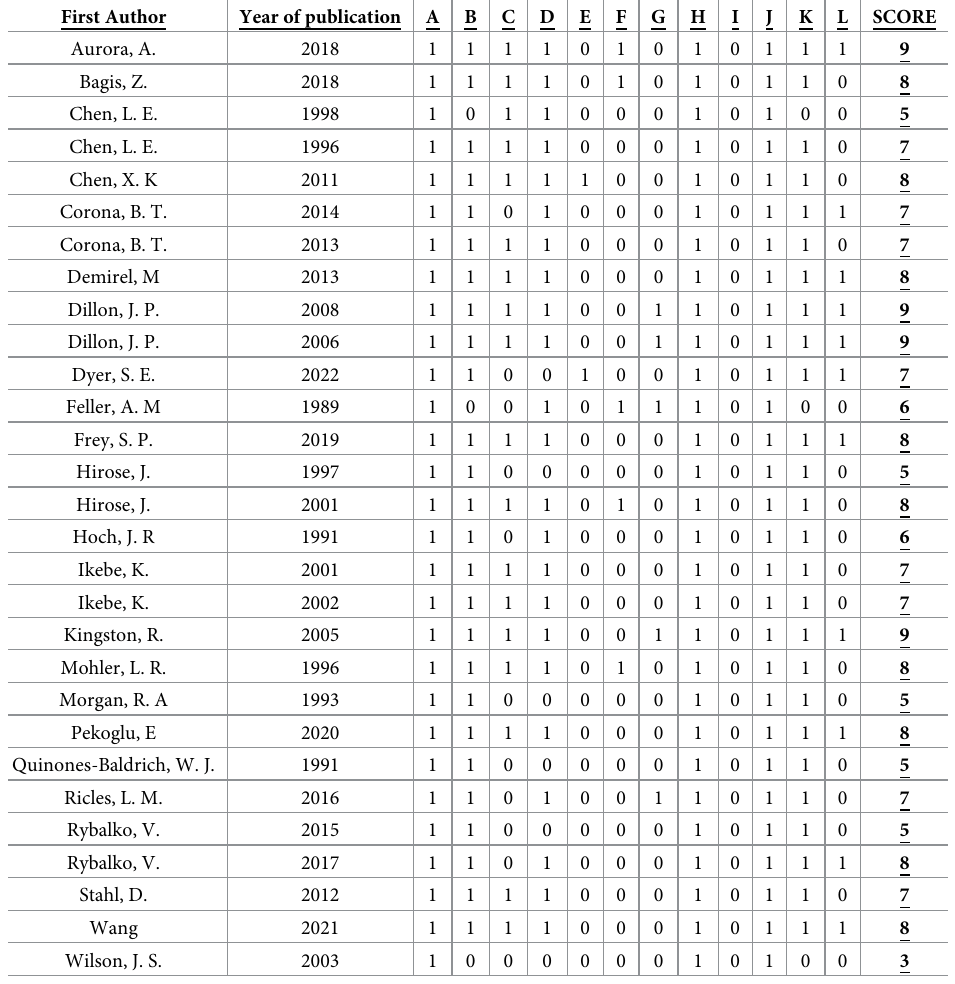
Table 3. Methodological qualities of each study and their